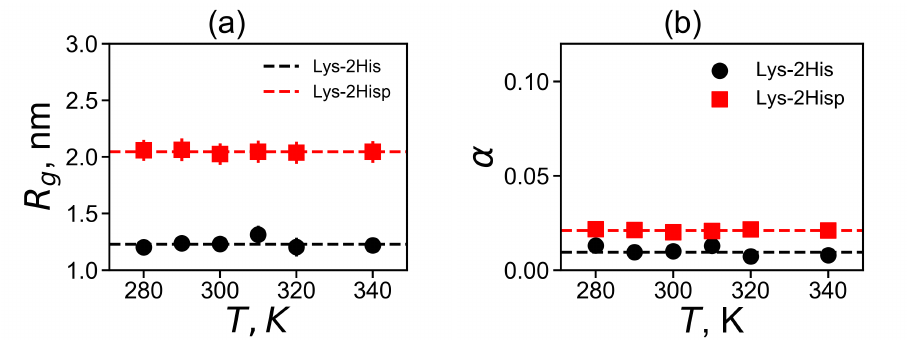
Figure 3. The temperature dependencies of ( a ) the mean-squared radius of gyration R g and ( b ) the shape anisotropy α . All data for Lys-2His and